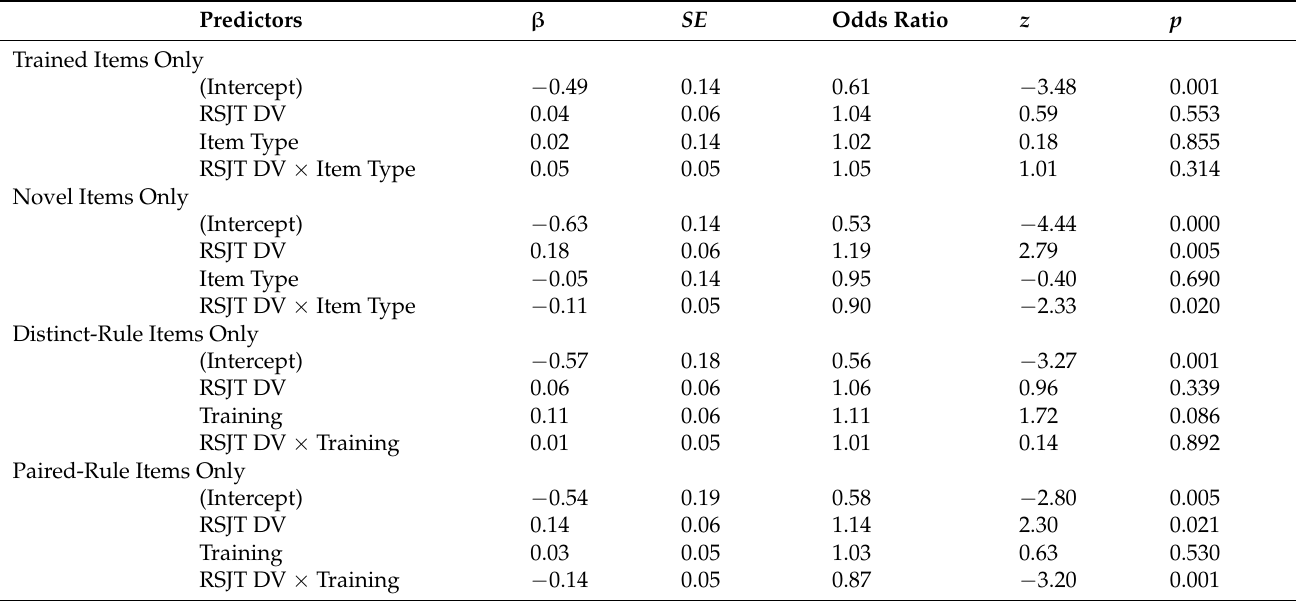
Table A2. Post hoc comparisons: RSJT different-version × training × item